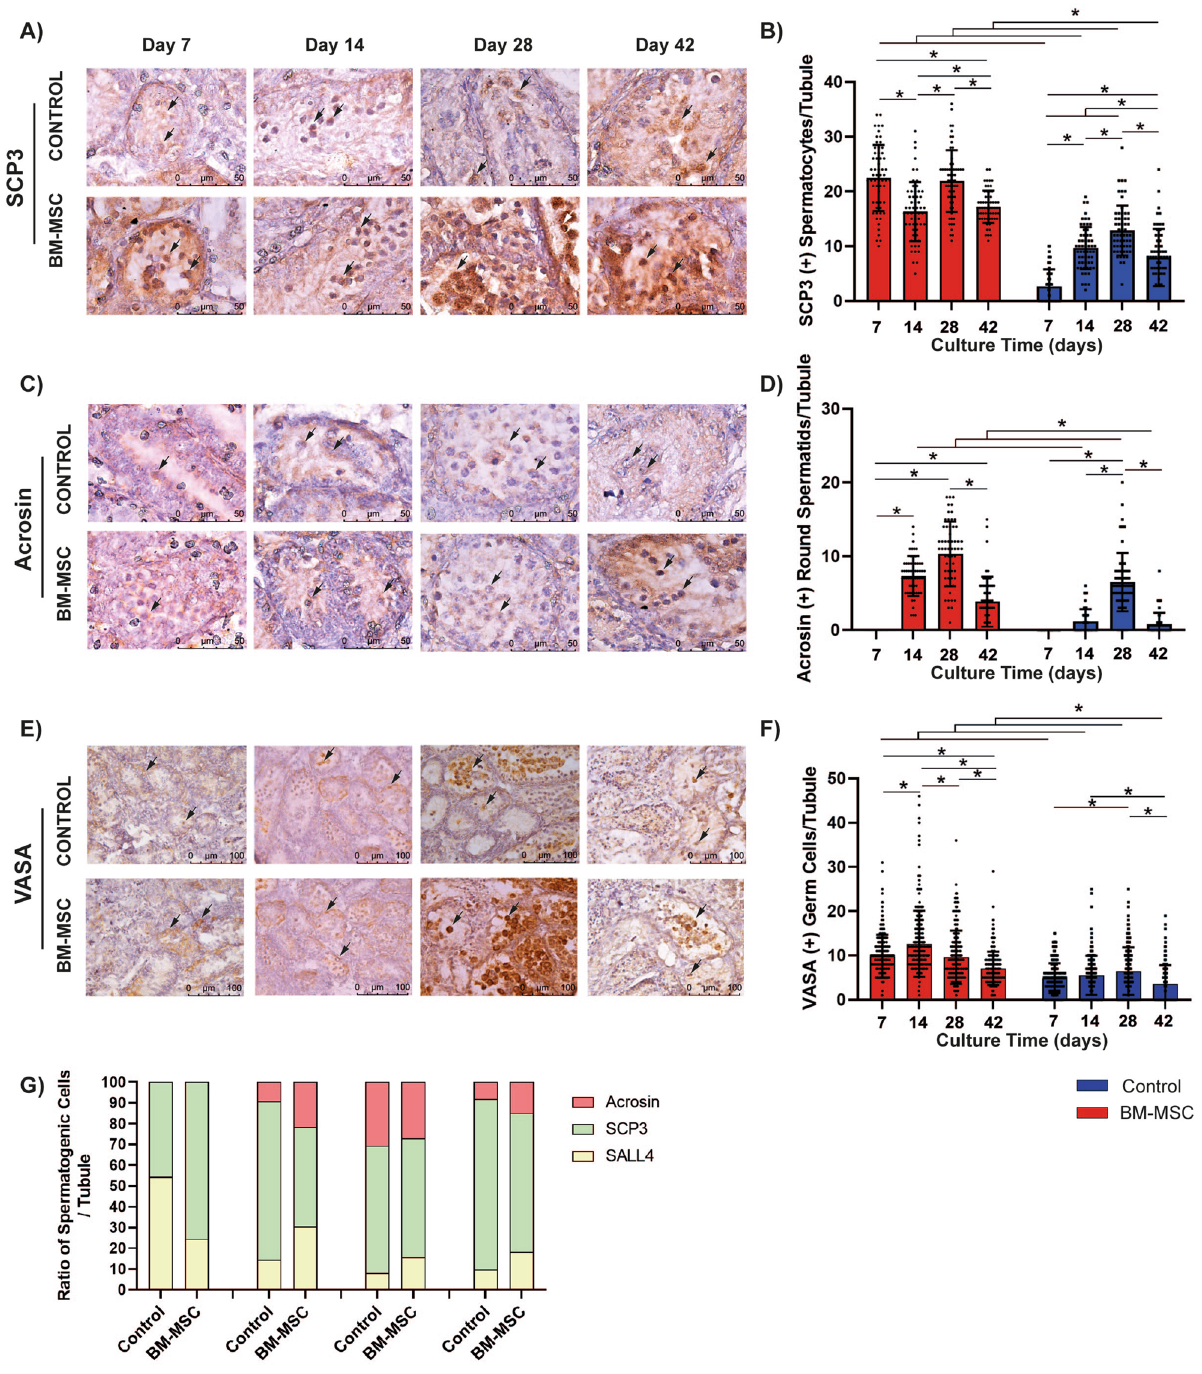
Figure 4. BM-MSCs promote spermatogenesis in vitro. Left column presents immune labeled micrographs of ( A ) SCP3, ( C ) Acrosin, ( E ) VASA in neonatal mouse testes cultured for 7, 14, 28 and 42 days (SCP3 and Acrosin: 1000x, VASA: 400x). Note the presence of spermatocytes and round spermatids indicated by arrow on SCP3 and Acrosin labeled sections, respectively. The right column presents bar graphs illustrating standard deviation and data distribution of time dependent change in ( B ) SCP3(+) ( D ) Acrosin(+) ( F ) VASA(+) GCs per seminiferous tubules (* p < 0.05, n = 6 testes, 300 tubules for VASA, 60 tubules for SCP3 and Acrosin). ( G ) The band graph represents the ratio of spermatogenic cells in seminiferous tubules (yellow: SALL4(+) SSPCs, green: SCP3(+) primary and secondary spermatocytes, red: Acrosin(+)